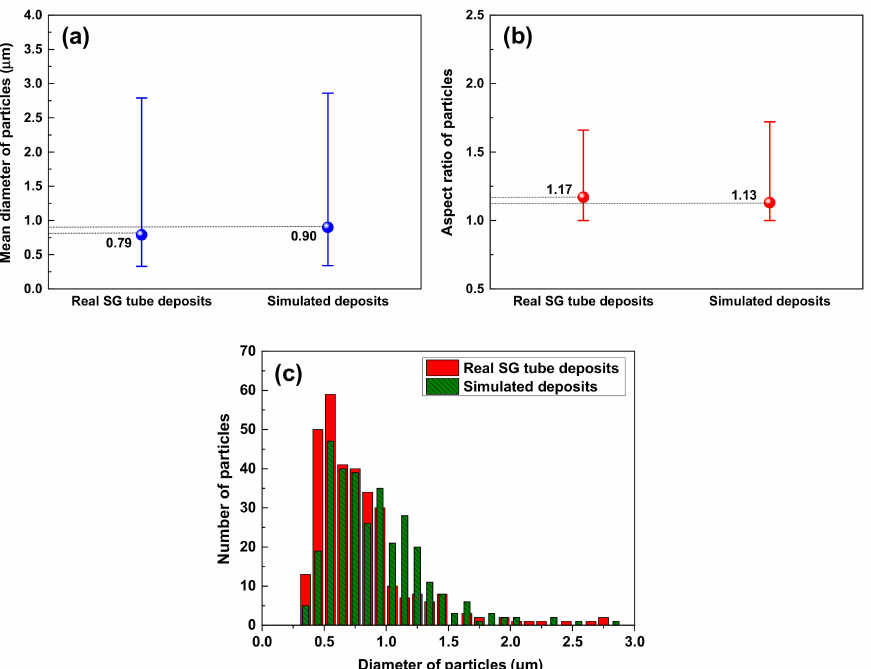
Figure 7. Particle size parameters of 320 randomly selected magnetite particles using an image analyzer: ( a ) mean diameter, ( b ) aspect ratio, and ( c ) particle size distribution.